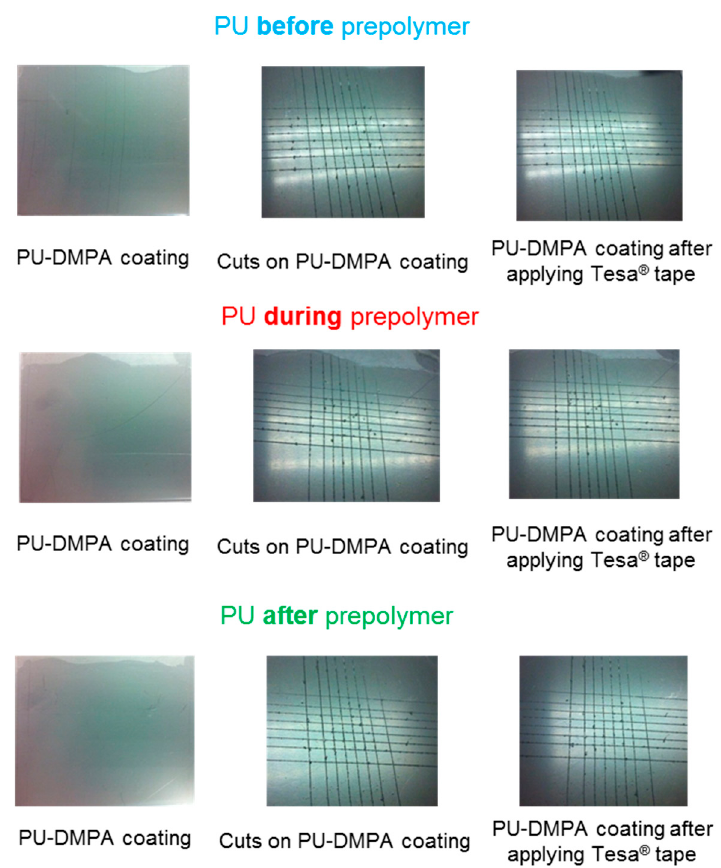
Figure 16. Appearance of the PU coatings synthesized by adding DMPA at different stages during synthesis on stainless steel plate. ASTM D3359-09 standard.